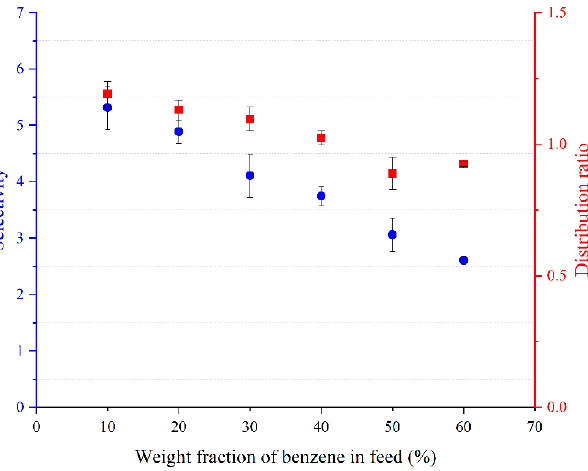
Figure 6. Variation of the distribution ratio and selectivity with benzene weight fraction in the feed for [Benzene (1) + Cyclohexane (2) + BTBACl:Cre (1:2) (3)].